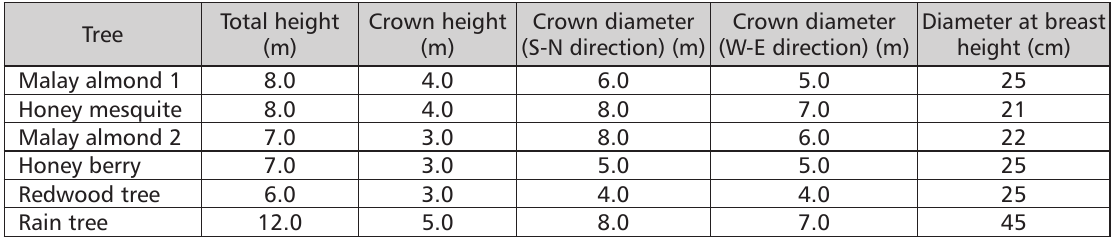
Precipitation value We selected six different kinds of shadows – six trees (Figure 4–9) and five different species: Malay almond 1 and Malay almond 2 ( Terminalia catappa ), Honey mesquite ( Prosopis juliflora), Honey berry ( Meliccoca bijuca ), Redwood tree ( Platysmincium pinatum ) and Rain tree ( Enterolobium ciclocarpum ). The trees chosen have between 8 and 12 meters (high total), 21 and 45 cm diameter trunk and bet- ween 4 and 8 m diameter of crown (Table